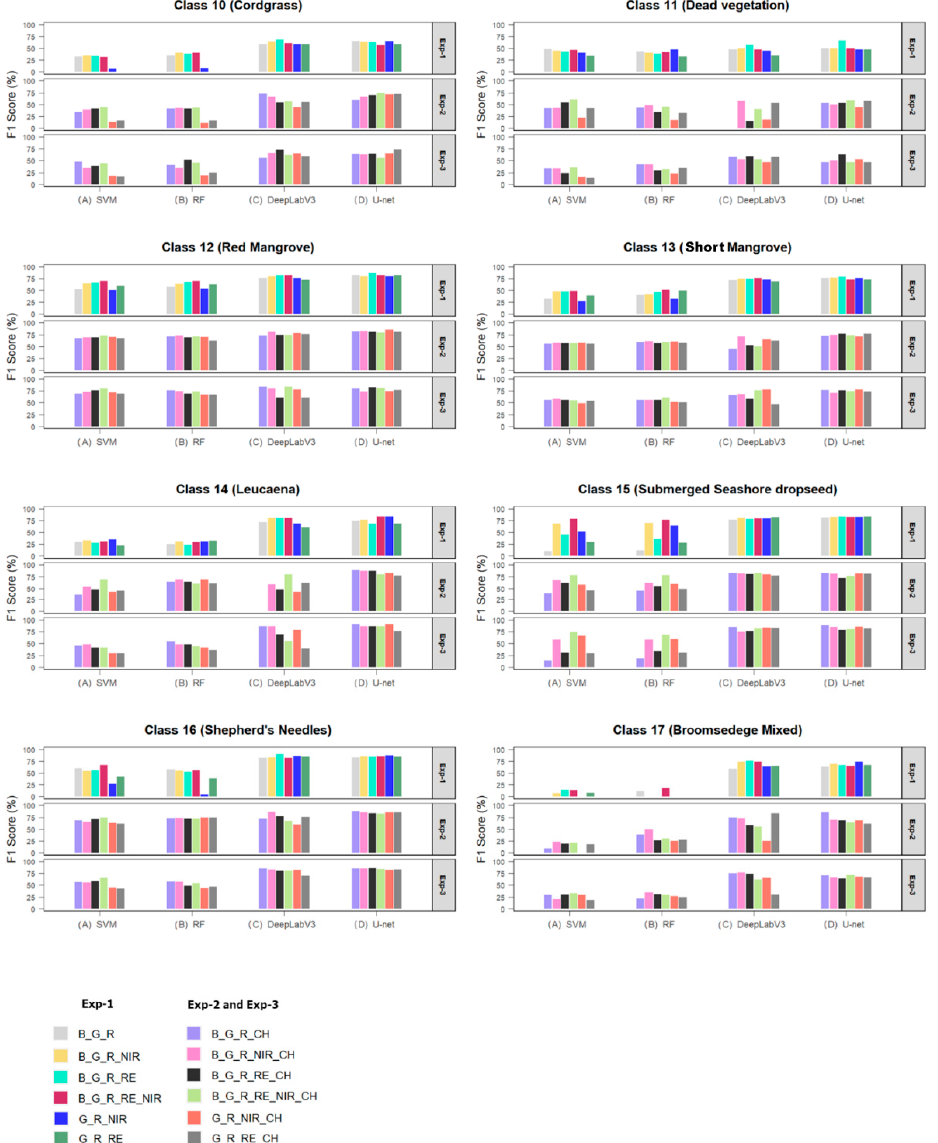
Figure 14. F1 scores organized by experiment, classification method and band combination, classes 10 to 17.